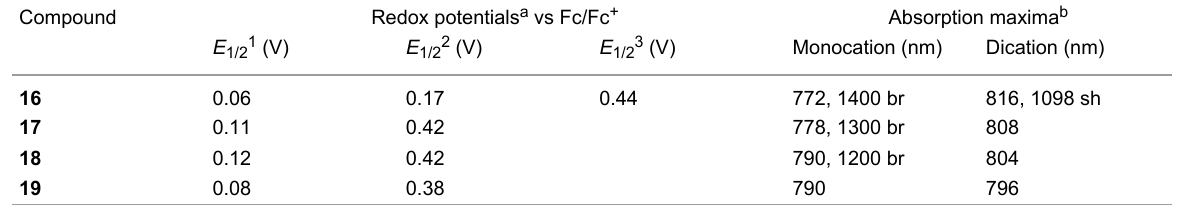
Table 1: Redox potentials of 16–19 and absorption maxima of monocations 16 •+ , 17 •+ , 18 •+ and 19 •+ , and dications 16 2+ , 17 2+ , 18 2+ and 19 2+ [25,59].